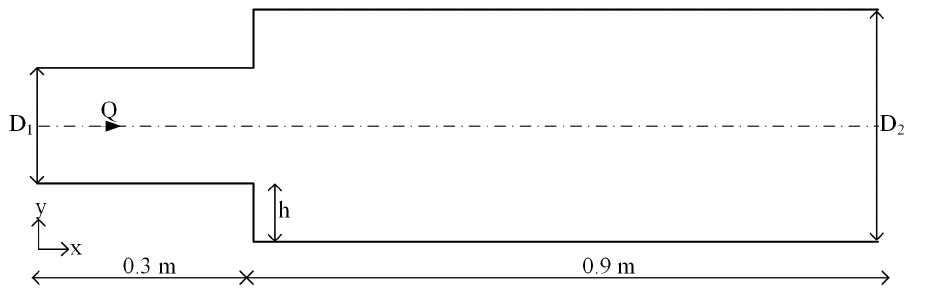
Figure 5. Geometry and dimensions of the validation case.